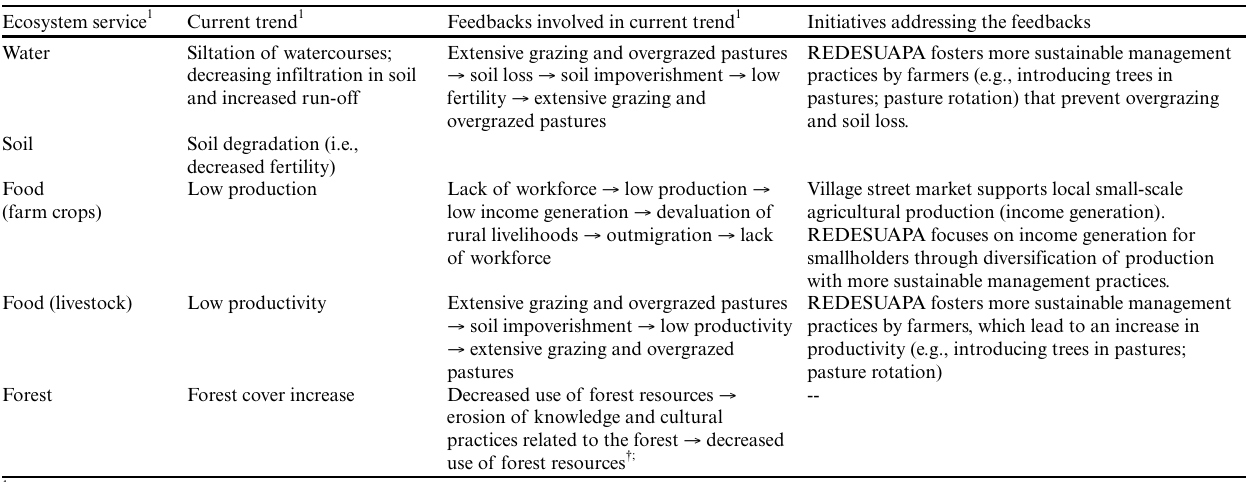
Table 1 . Current trend for the critical ecosystem services, the respective feedback mechanisms involved, and how they are being addressed by the environmental initiatives currently taking place in the Chapéu River watershed, São Luiz do Paraitinga municipality, southeast Brazil. REDESUAPA = Portuguese acronym for The Upper Paraíba River Sustainable Development